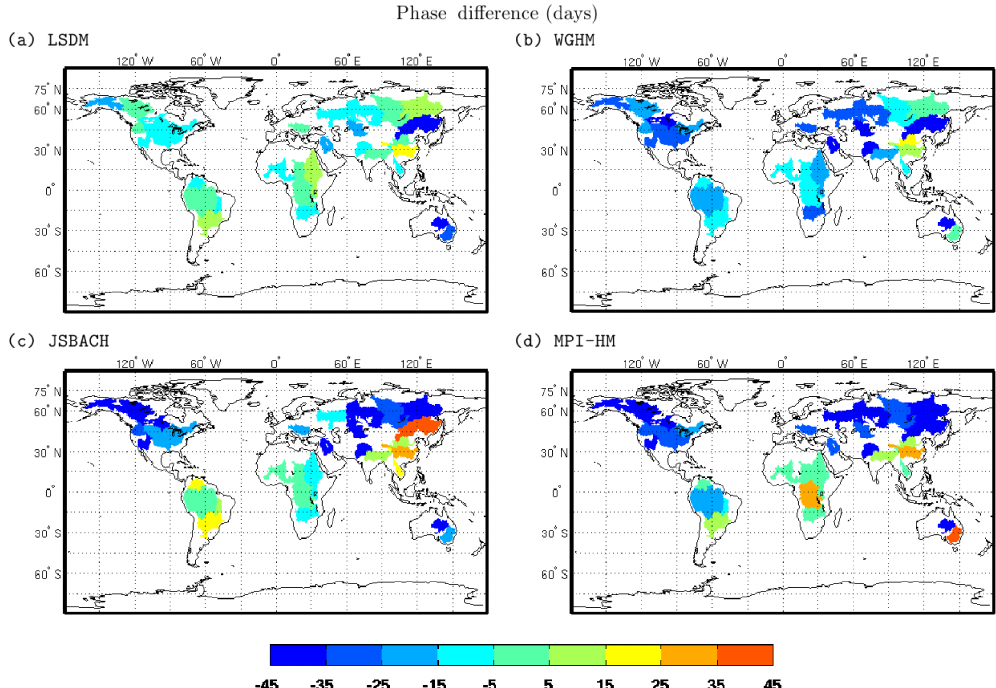
Figure 3. Phase differences for the annual signal of four hydrological model realizations with GRACE-based TWS observations.